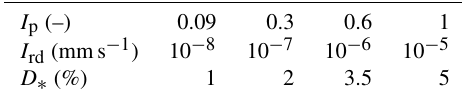
Table 4. Range of values on each parameter tested for use in cali-